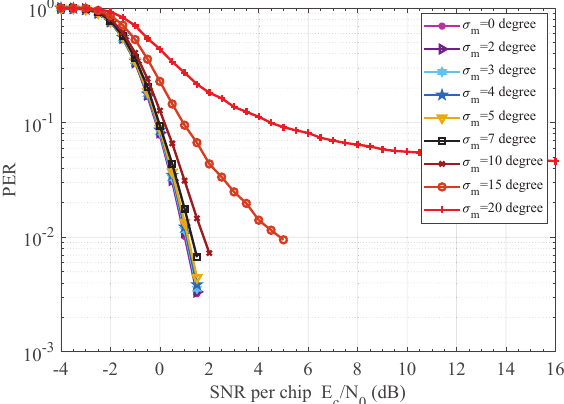
Figure 13. PER performance of proposed receiver versus dynamic CPO. CPO: carrier phase